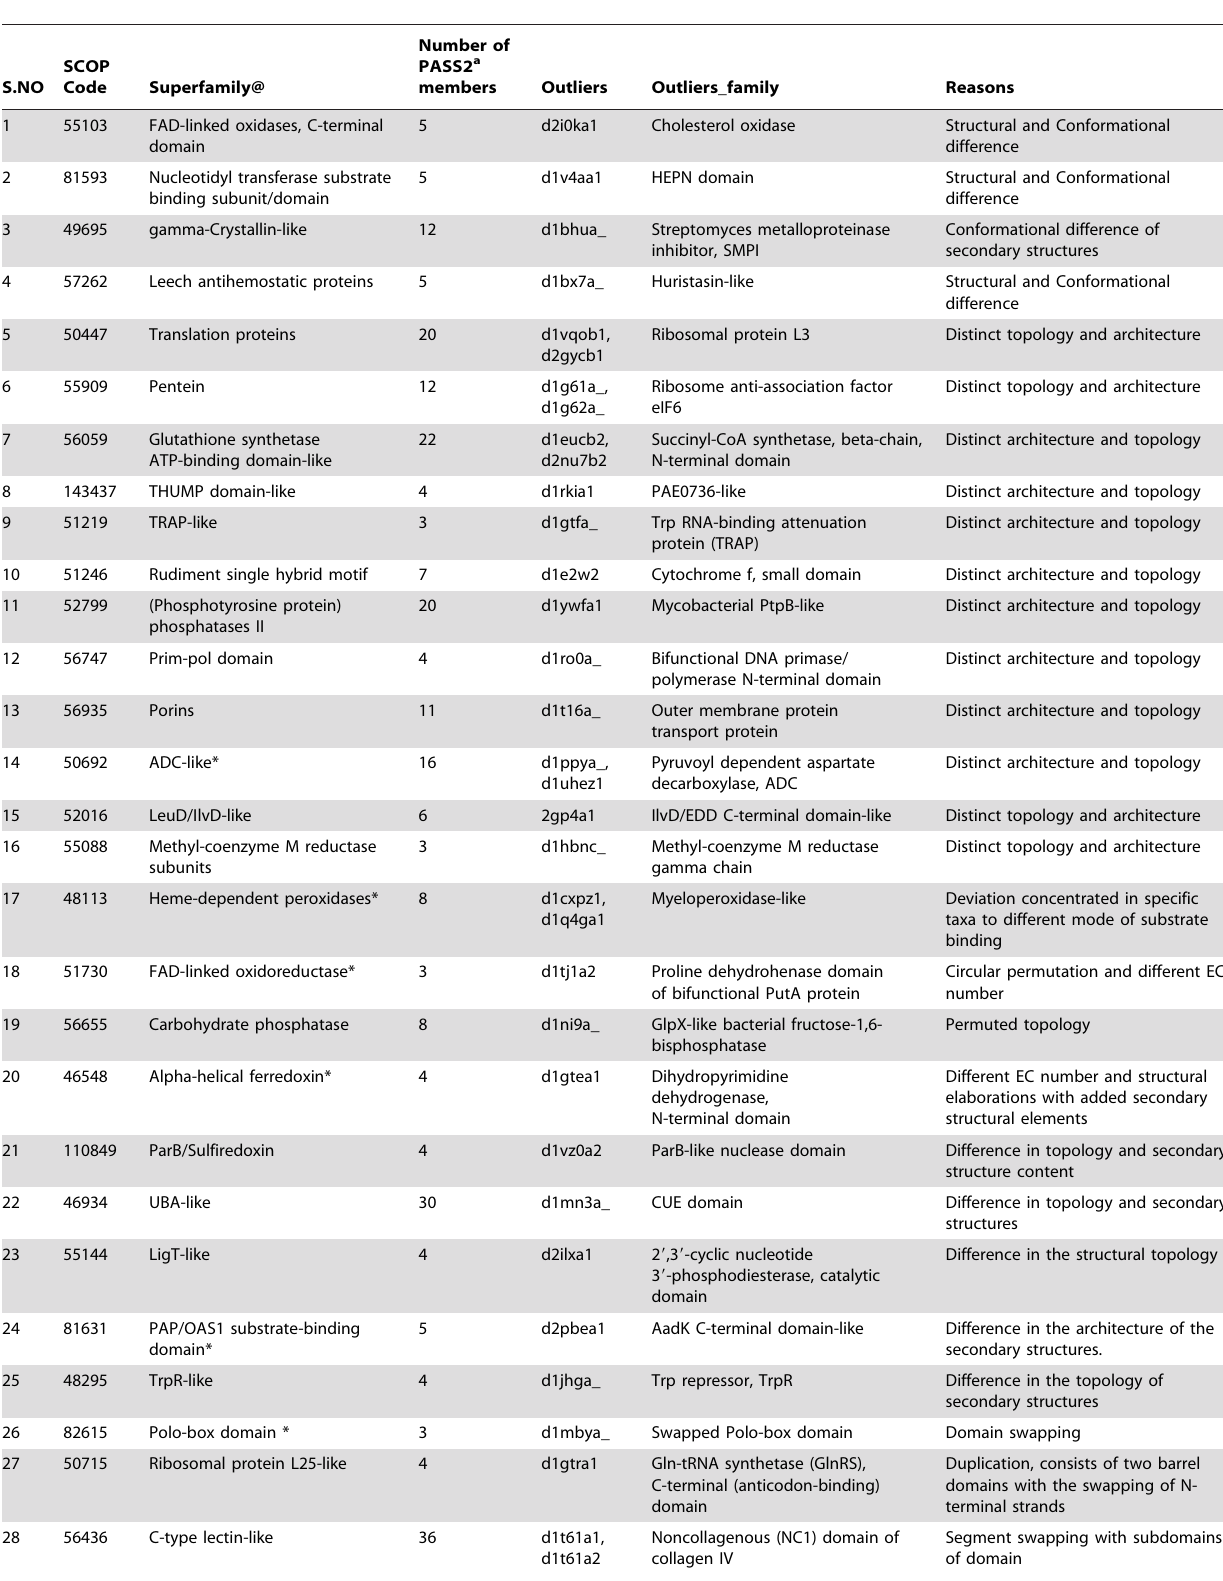
Table 1. Details of all family-specific outliers in PASS2 a multi-member superfamilies.